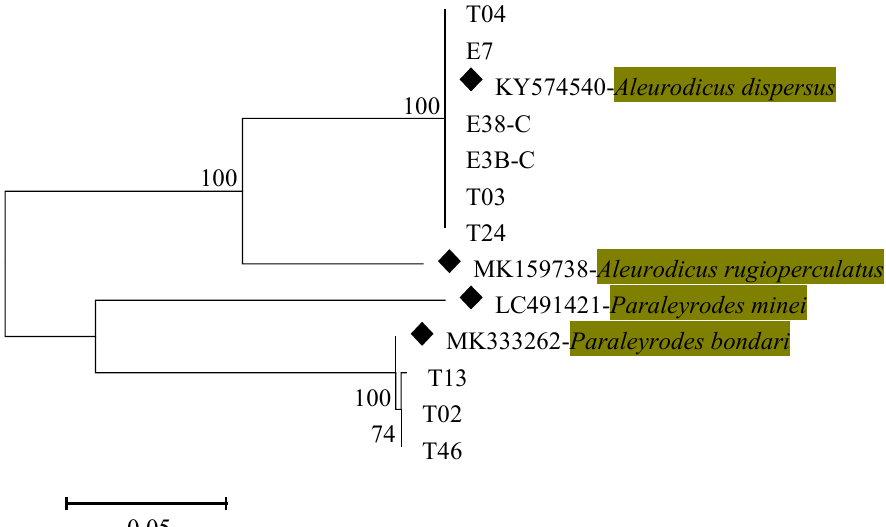
Figure 3. Maximum likelihood phylogenetic tree constructed using mitochondrial cytochrome oxidase 1 sequences obtained from non- Bemisia whitefly species collected on cassava plants in Kenya between July 2018 and July 2020. Reference sequences ( (cid:117) ) from NCBI were included for comparison.